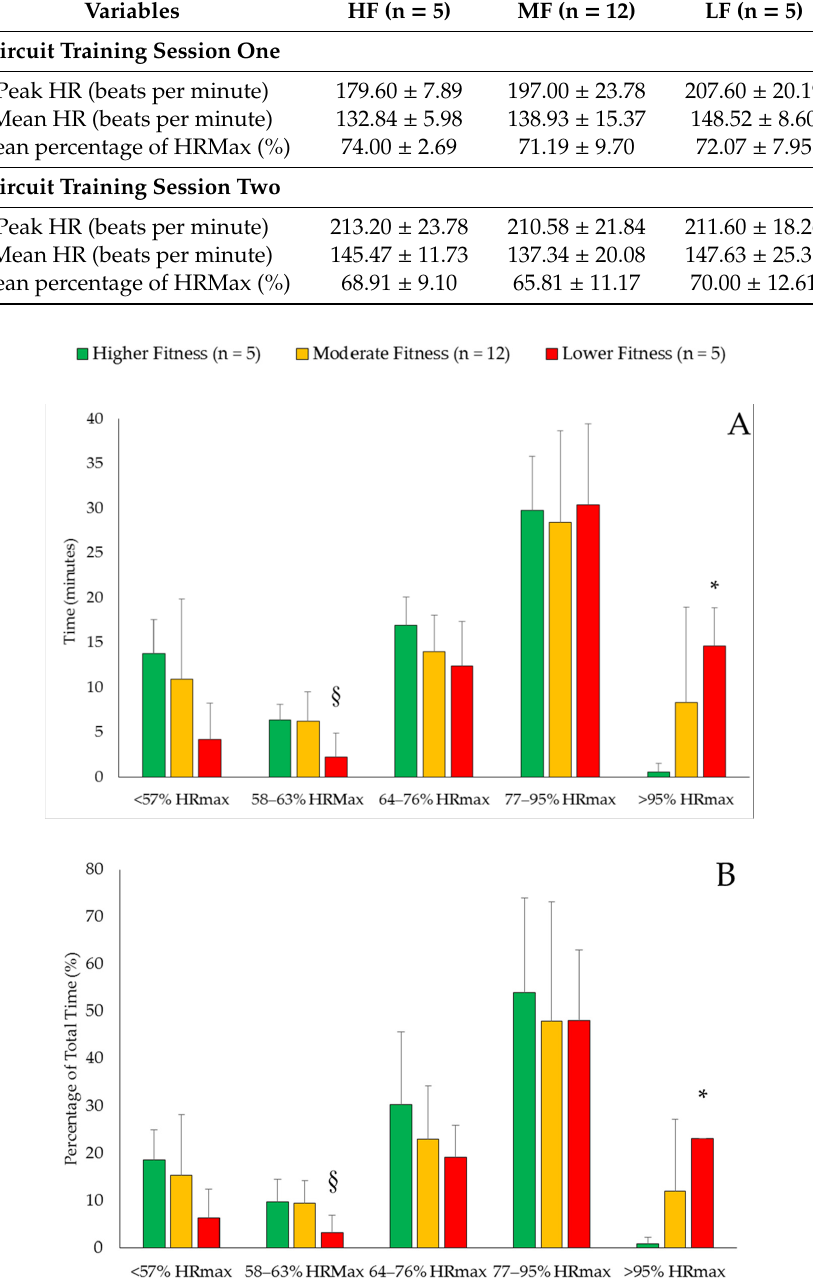
Table 3. Descriptive data (mean ± SD) for peak heart rate (HR), mean HR, and mean percentage of age-predicted heart rate maximum (%HR Max) for higher fitness (HF), moderate fitness (MF), and lower fitness (LF) custody assistant recruits in the two circuit training sessions.